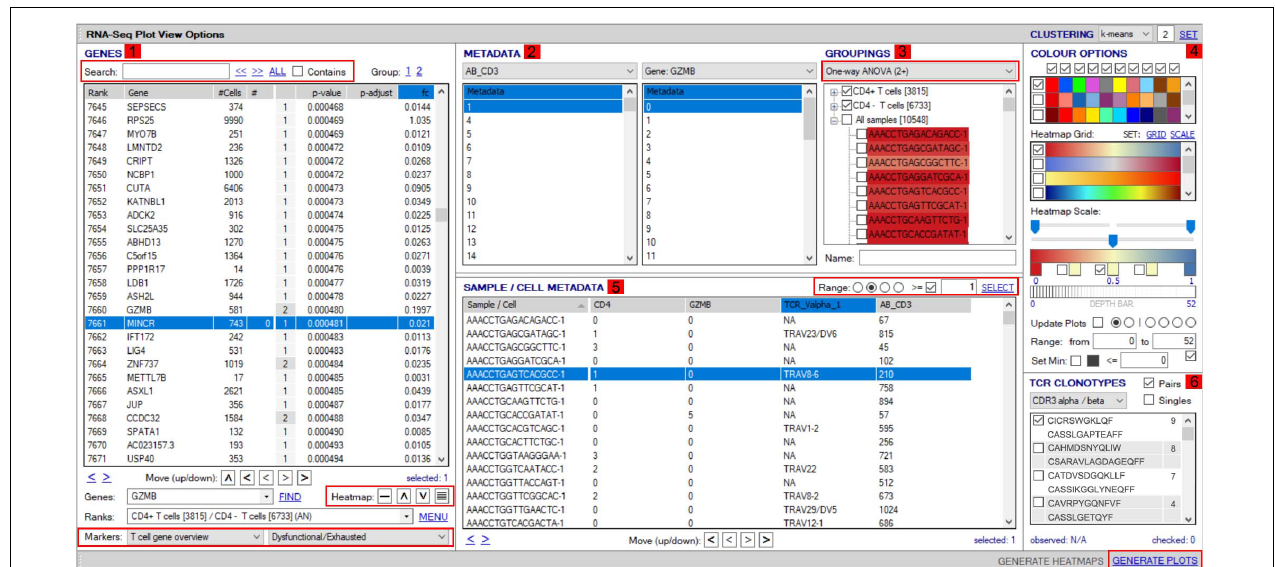
FIGURE 4 | Workflow for analyses of scTCR–RNA-seq data using VGAS plot viewer window. The scTCR–RNA-seq analysis home screen window is divided into key domains to help direct analyses by the user. (1) “Genes” panel lists all genes expressed with options to search for specific genes of interest (highlighted red), reorder, and find literature determined groups of interest genes using the “Markers” dropdown tab or heatmap (highlighted red) individual genes on the UMAP for selected sample. (2) “Metadata” is displayed with dropdown tabs to select data by sample, clinical metadata, or phenotype groupings defined by indexed flow data or via unsupervised K means clustering on whole sample with consensus calling from reference atlas databases. (3) Grouped data/clusters appear in the “Groupings” domain for selection and differential analyses using a range of statistical algorithms contained in the dropdown tab (highlighted red). Differential gene analysis results provide p -value, p -adjusted, and fold change displayed in “Genes” panel. (4) Groups and plots can be fully color-customized in the “Color options” panel and heatmap scales set to user preference. (5) Genes of interest, metadata, or groupings can be saved and set as metadata for further interrogation or grouping by several parameters in the “Sample/cell metadata panel.” User-defined positive cutoff range for numerical data can be applied to filter samples using “Range” function toggle (highlighted red). (6) scTCR-seq defined clonotypes can be set from whole data or distinct RNA-defined groups in the “TCR clonotypes” domain. Circos plots can also be generated from within this panel. The “generate plots” function, bottom right (highlighted red), provides access to associated